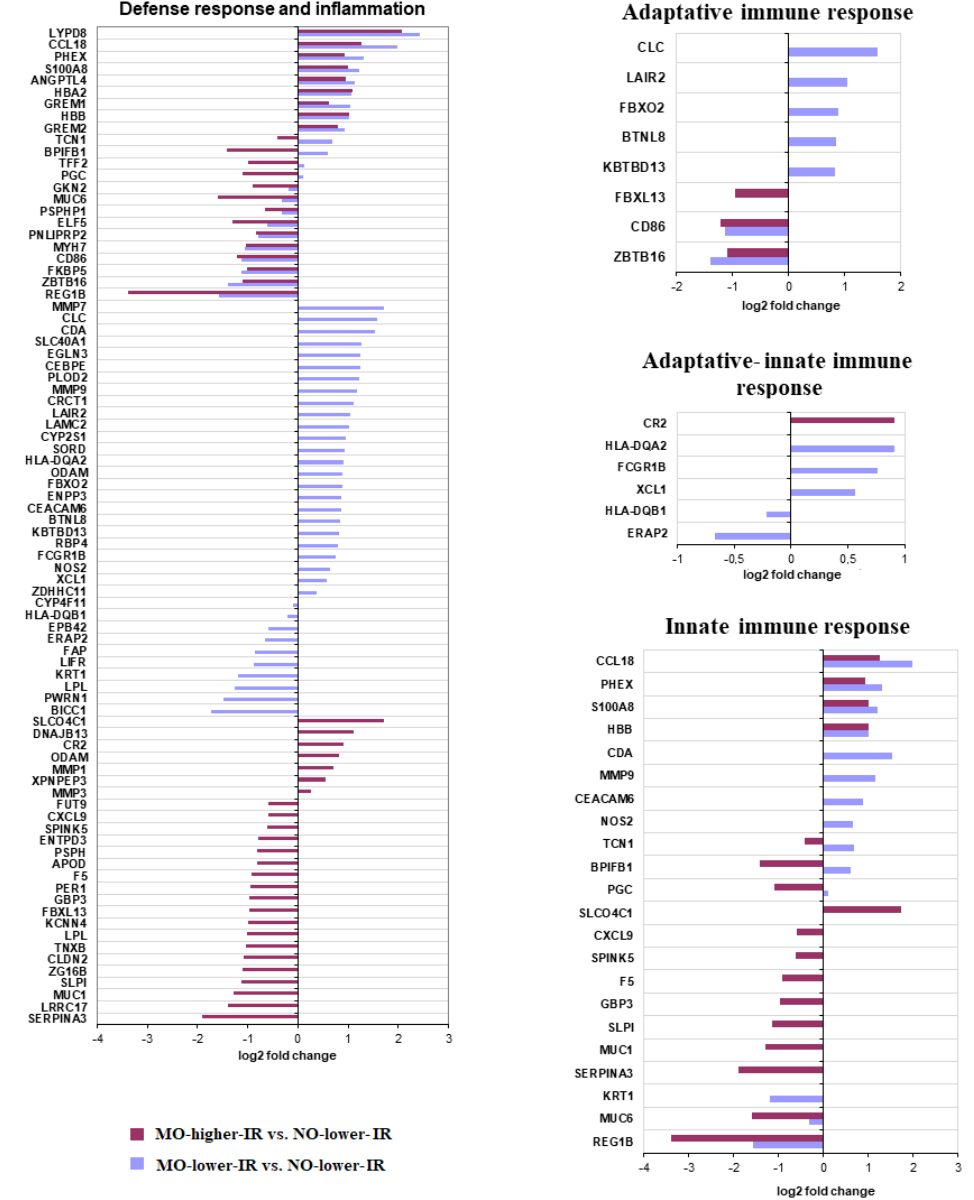
Figure 3. Representation of the Log 2 of fold change of the differentially expressed genes (DEGs) included in the overrepresented gene sets (FDR < 0.05) related to defense response, inflammation, and innate and adaptive immune responses.